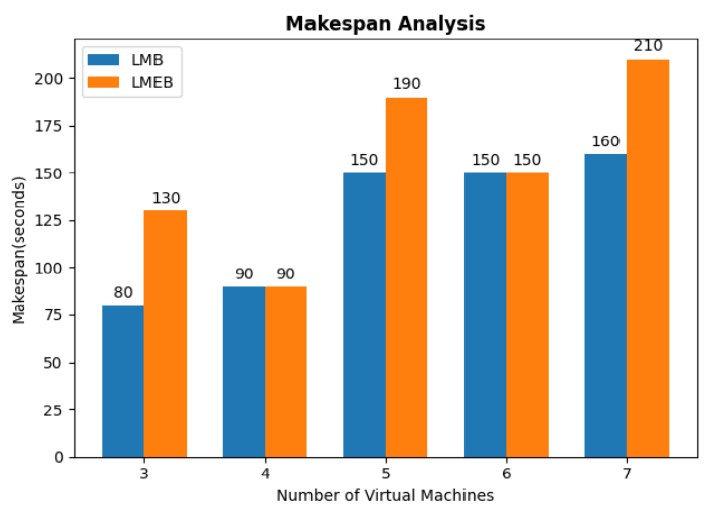
Figure 8. Makespan analysis.